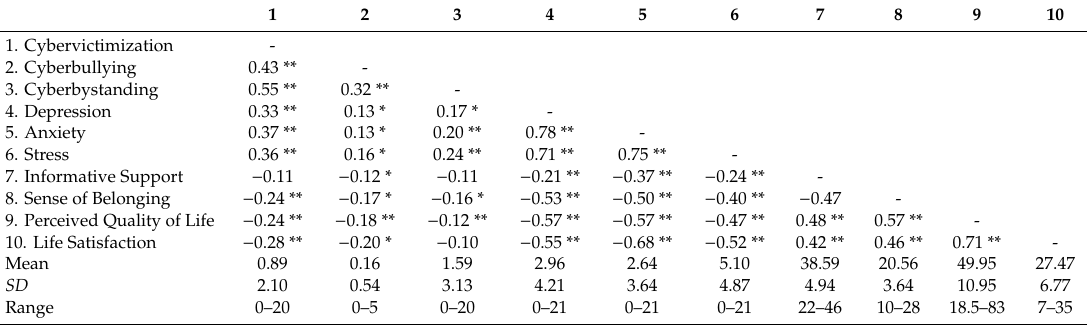
Table 3. Means and standard deviations and partial correlations controlling for age between the dimensions of study ( n = 255).